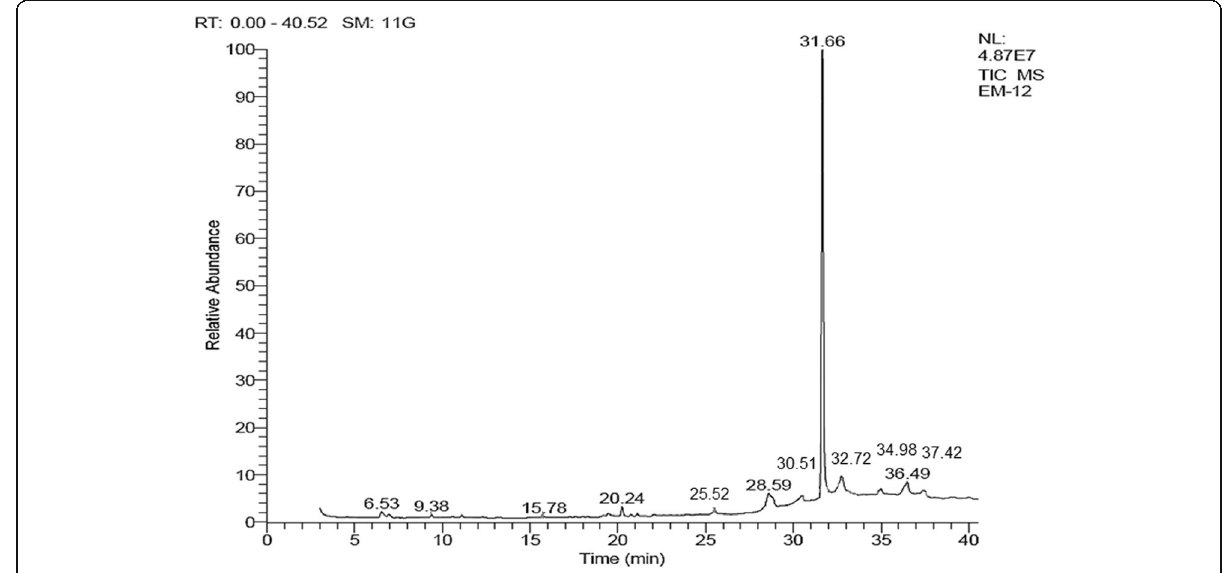
Fig. 2 GC Chromatogram of A. hydaspica crude methanol extract